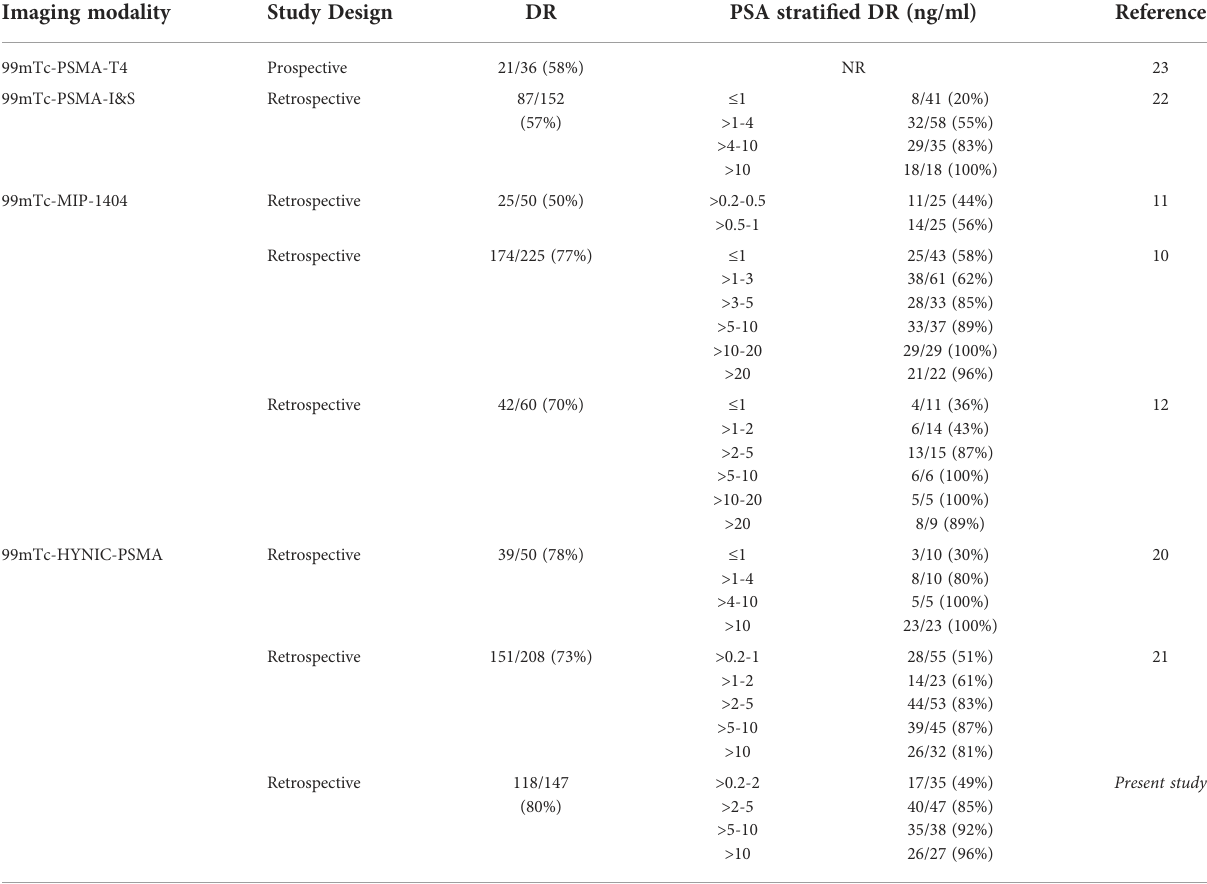
TABLE 4 Summary detection rate of series reporting 99mTc-labled PSMA for biochemical recurrence of PCa. Imaging